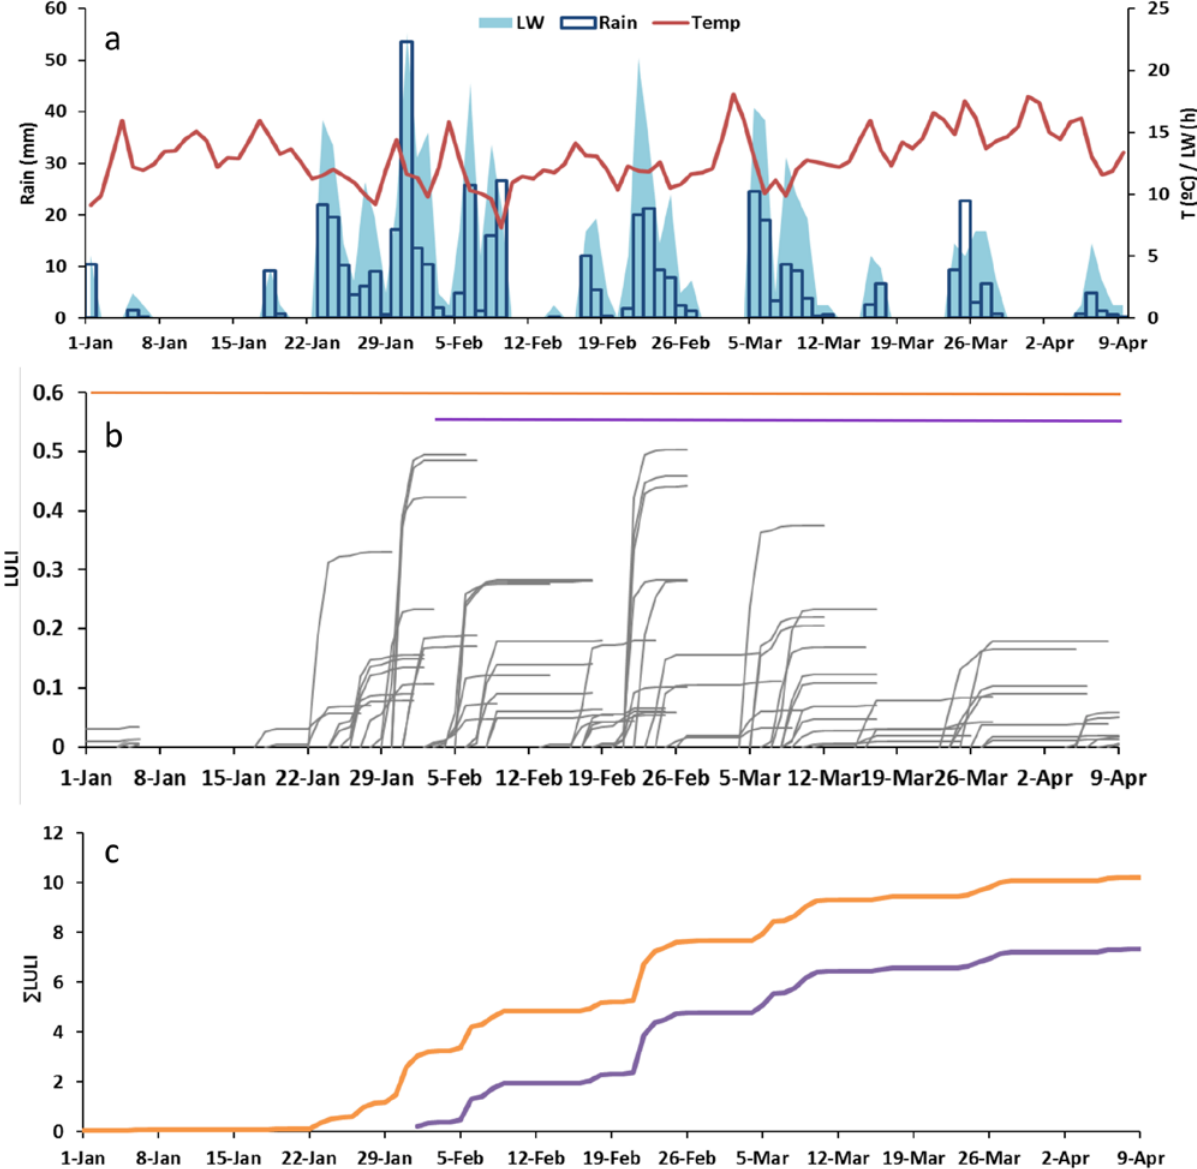
Figure 4. Weather data and model output for 2015. a: daily weather data; b: predicted increase of latent infections (LULI) for each infection period; c: predicted seasonal dynamics of the cumulative values of LULI (∑LULI) for cv. Peluche and Algerie (orange line) and for cv. San Filipparo (purple line). Coloured lines at the top in b represent the periods in which the model was operated for cv. Peluche and Algerie (orange line) and for cv. San Filipparo (purple